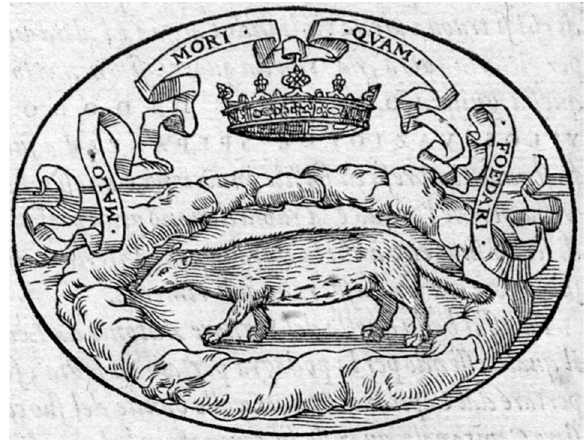
Figure 14. Impresa of the ermine (MALO MORI QUAM FOEDARI), c. 1574. In (Giovio 1574). Image in the public domain.